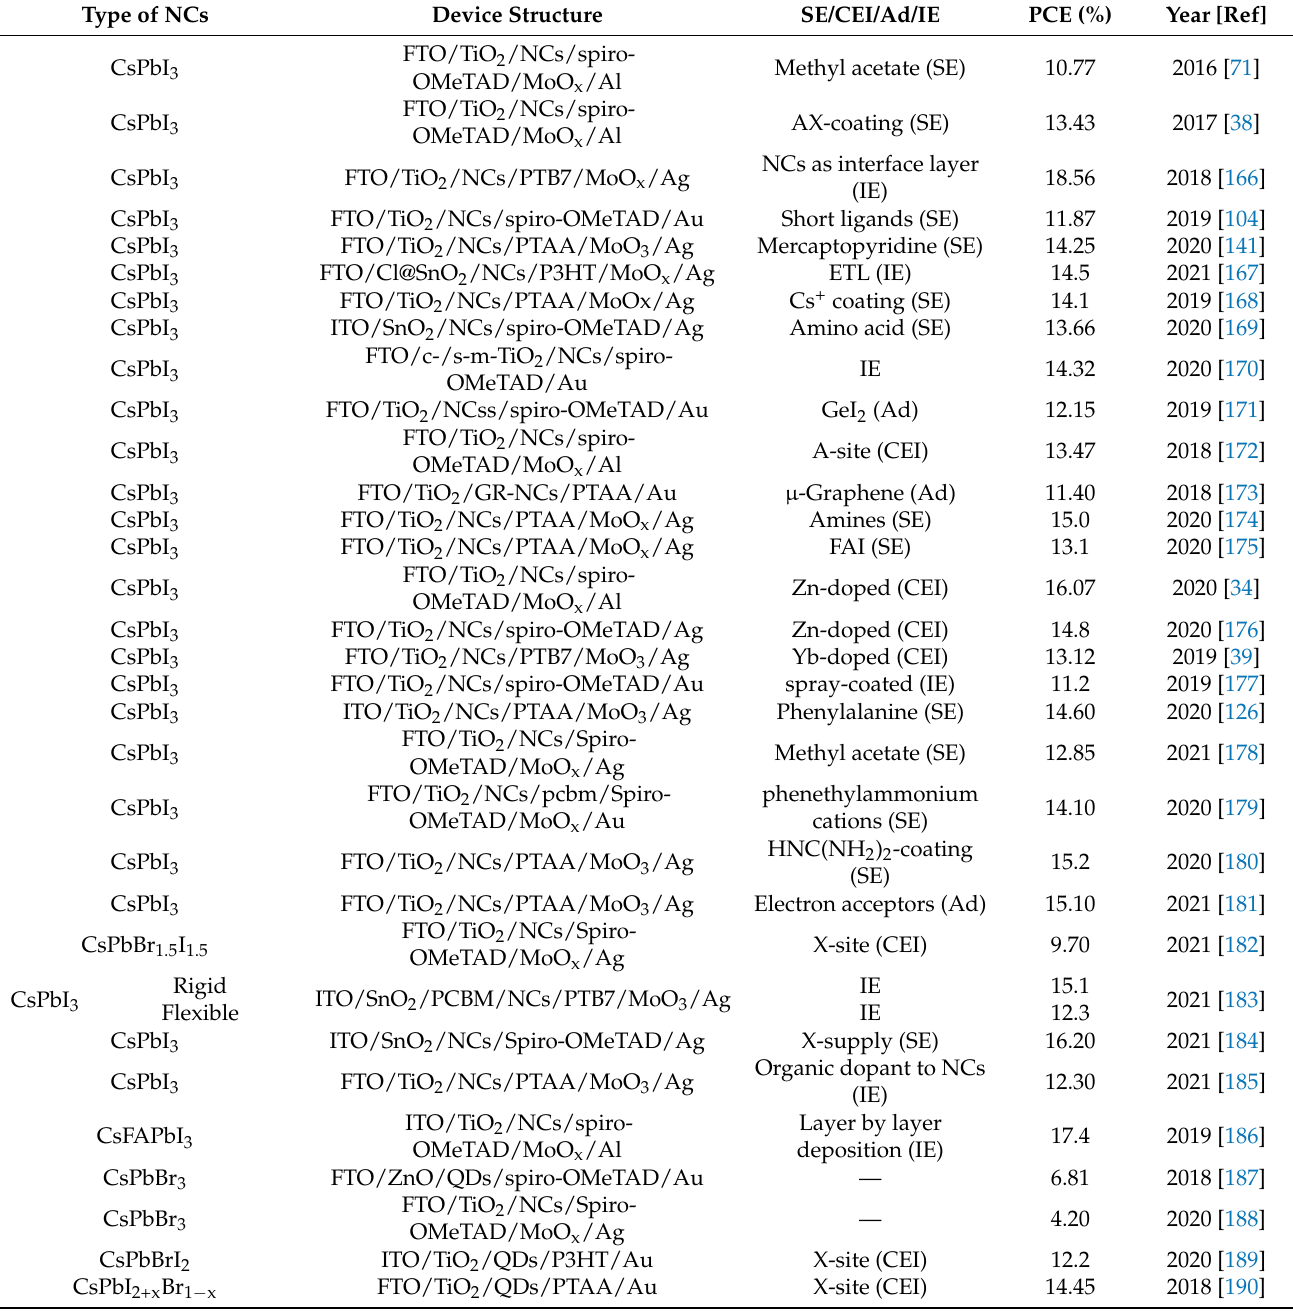
Table 1. Summary of PSCs fabricated base on CsPbI 3 NCs and their variants, respective methods to receive the improved